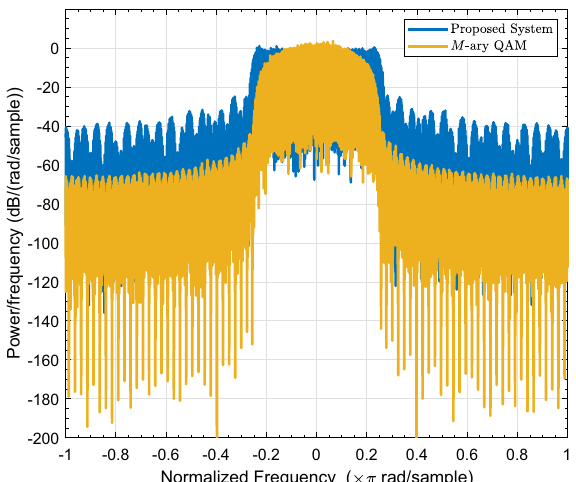
Fig. 11 Spectrum comparison between the conventional QAM system using RRC pulse shaping and the proposed IQ-FSIM system using 2 non-optimal